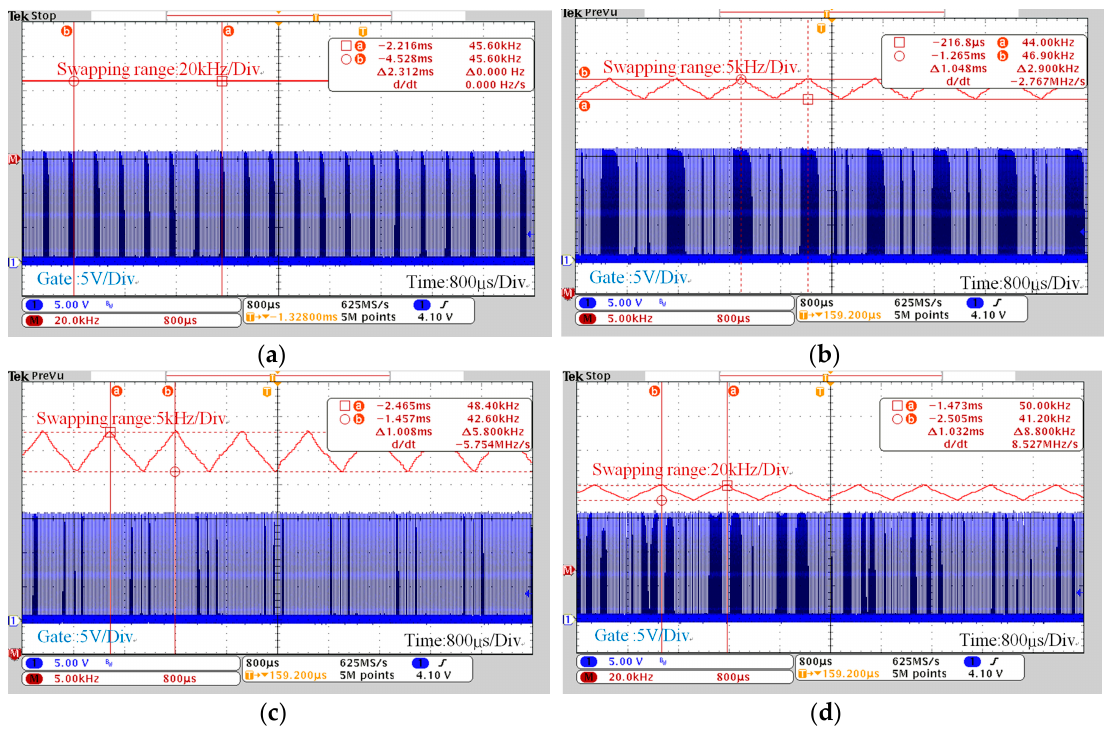
Figure 19. Measurement of operating frequencies. ( a ) no frequency swapping; ( b ) frequency swapping range set at ± 3%; ( c ) frequency swapping range set at ± 6%; and ( d ) frequency swapping range set at ±